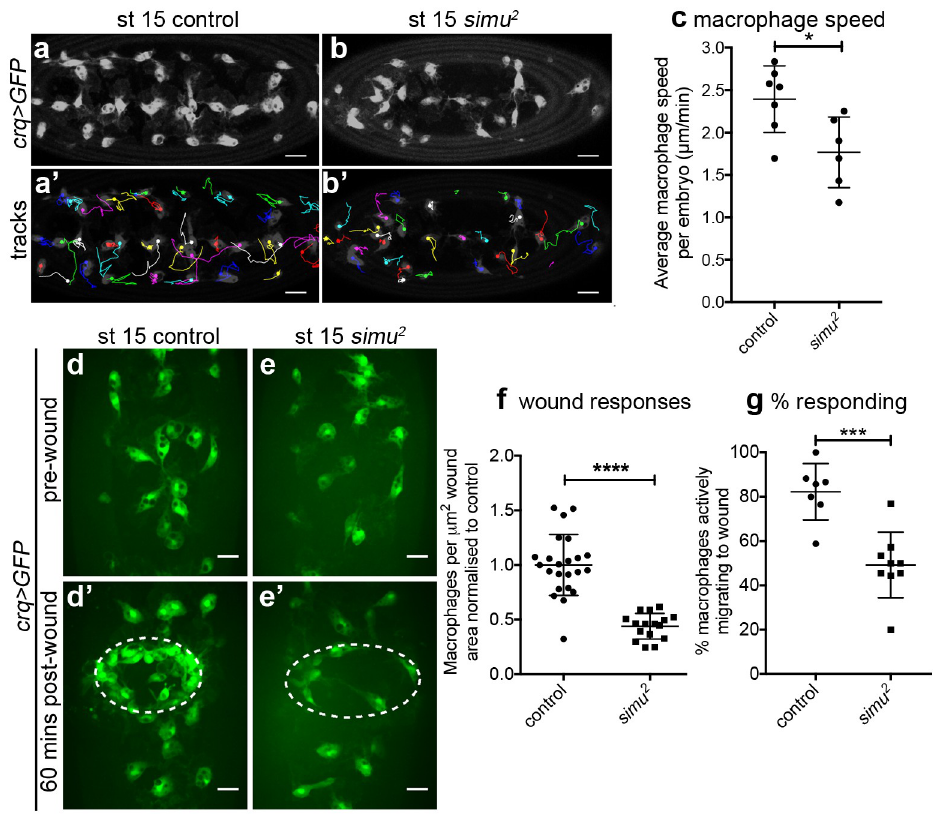
Fig 4. Pathological levels of apoptosis impair motility of macrophages and inflammatory migration to wounds. (a–b) Images of GFP-labelled macrophages and their associated tracks on the ventral midline at stage 15 in control ( w;; crq-GAL4 , UAS-GFP , a) and simu mutant ( w;simu 2 ; crq-GAL4 , UAS-GFP , b) embryos. (a’–b’) Tracks show macrophage migration over a 30-minute period; dots show starting positions of those macrophages present in the first frame of the movie; anterior is left. (c) Scatterplot of average speed per macrophage, per embryo on the ventral midline at stage 15 in μ m per min in controls and simu mutants ( n = 7 and 6, respectively; P = 0.035, Mann–Whitney test). (d–e) Images of GFP-labelled macrophages on the ventral midline in stage 15 control (d–d’) and simu mutant (e–e’) embryos before (d–e) and at 60-minutes post wounding (d’–e’). Dotted lines indicate wound sites. (f) Scatterplot of wound response at 60 minutes (number of macrophages at wound divided by wound area, normalised to control average) in control and simu mutant embryos ( n = 23 and 16, respectively; P < 0.0001, Mann–Whitney test). (g) Scatterplot showing percentage of macrophages responding to wounds (percentage of those in field of view at t = 0 not initially in contact with the wound site that reach the wound site in a 60-minute movie) in control and simu mutant embryos ( n = 7 and 9, respectively; P = 0.0006, Mann–Whitney test). All genotypes as per (a–b). Lines and error bars show mean and standard deviation; � , ��� , and ���� denote P < 0.05, P < 0.001, and P < 0.0001 (c, f, g); scale bars represent 20 μ m (a– b) and 10 μ m (d–e). All data used to plot graphs may be found in Supporting information file S1 Data. GFP, green fluorescent protein; UAS, upstream activating